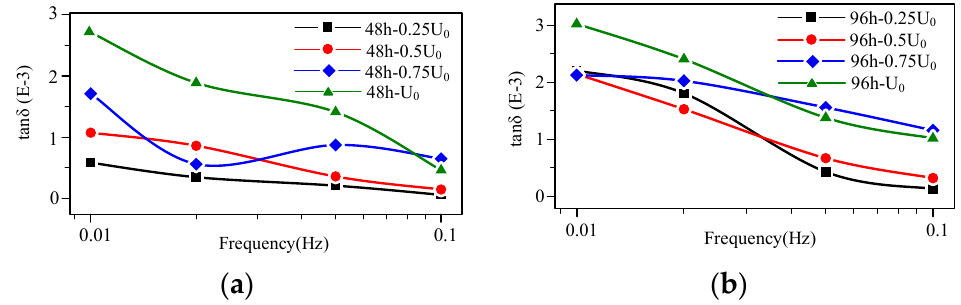
Figure 9. High-voltage FDS of cable at the early aging stage: ( a ) aging time 48 h; ( b ) aging time 96 h. The high-voltage FDS curves of the cable at the middle aging stage (192–384 h) are shown in Figures 7 and 10a, respectively. According to Figure 7, the tan δ value continues to increase with the aging degree. In particular, starting from a higher voltage level ( U 0 ), the tan δ -f curves gradually increase as the detection voltage rises at each frequency point, meaning the FDS curves start to show a layered phenomenon. Correspondingly, according to the results in Section 3.1, at this aging time point, the mechanical properties begin to show a declining trend, the polar products increase, and dislocation defects begin to appear in the crystal region.